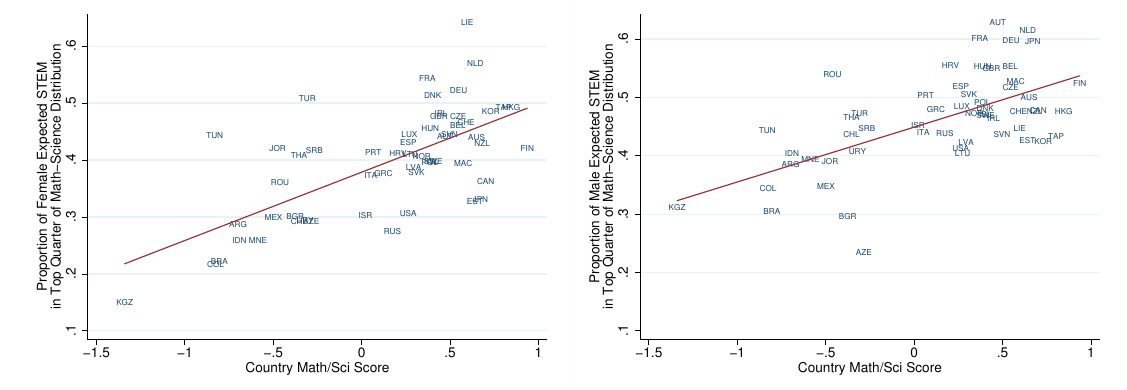
Figure 7: Proportion of male and female STEM-oriented students in the top quarter of the math-science distribution by national math-science performance